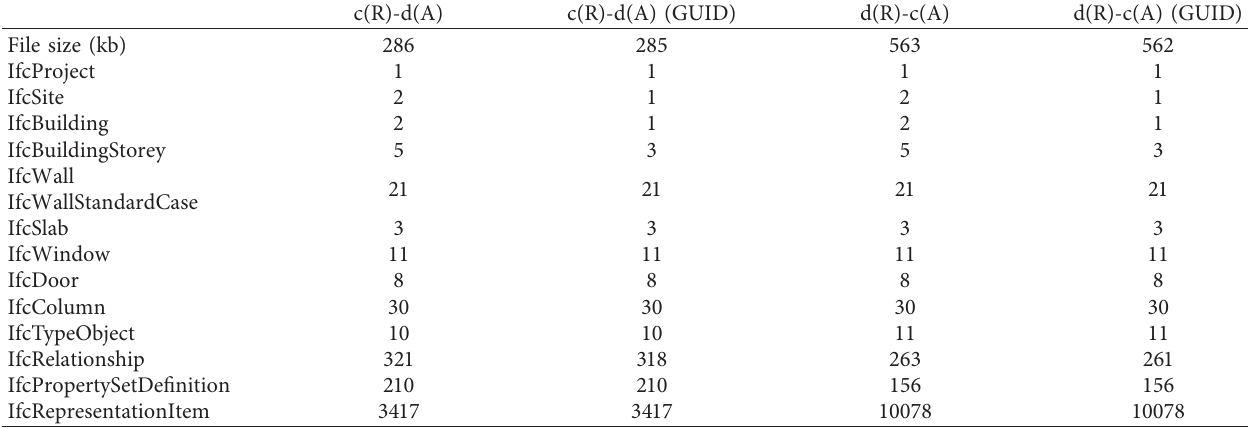
Table 5: Entity statistics for scenarios c and d in different modeling environments.